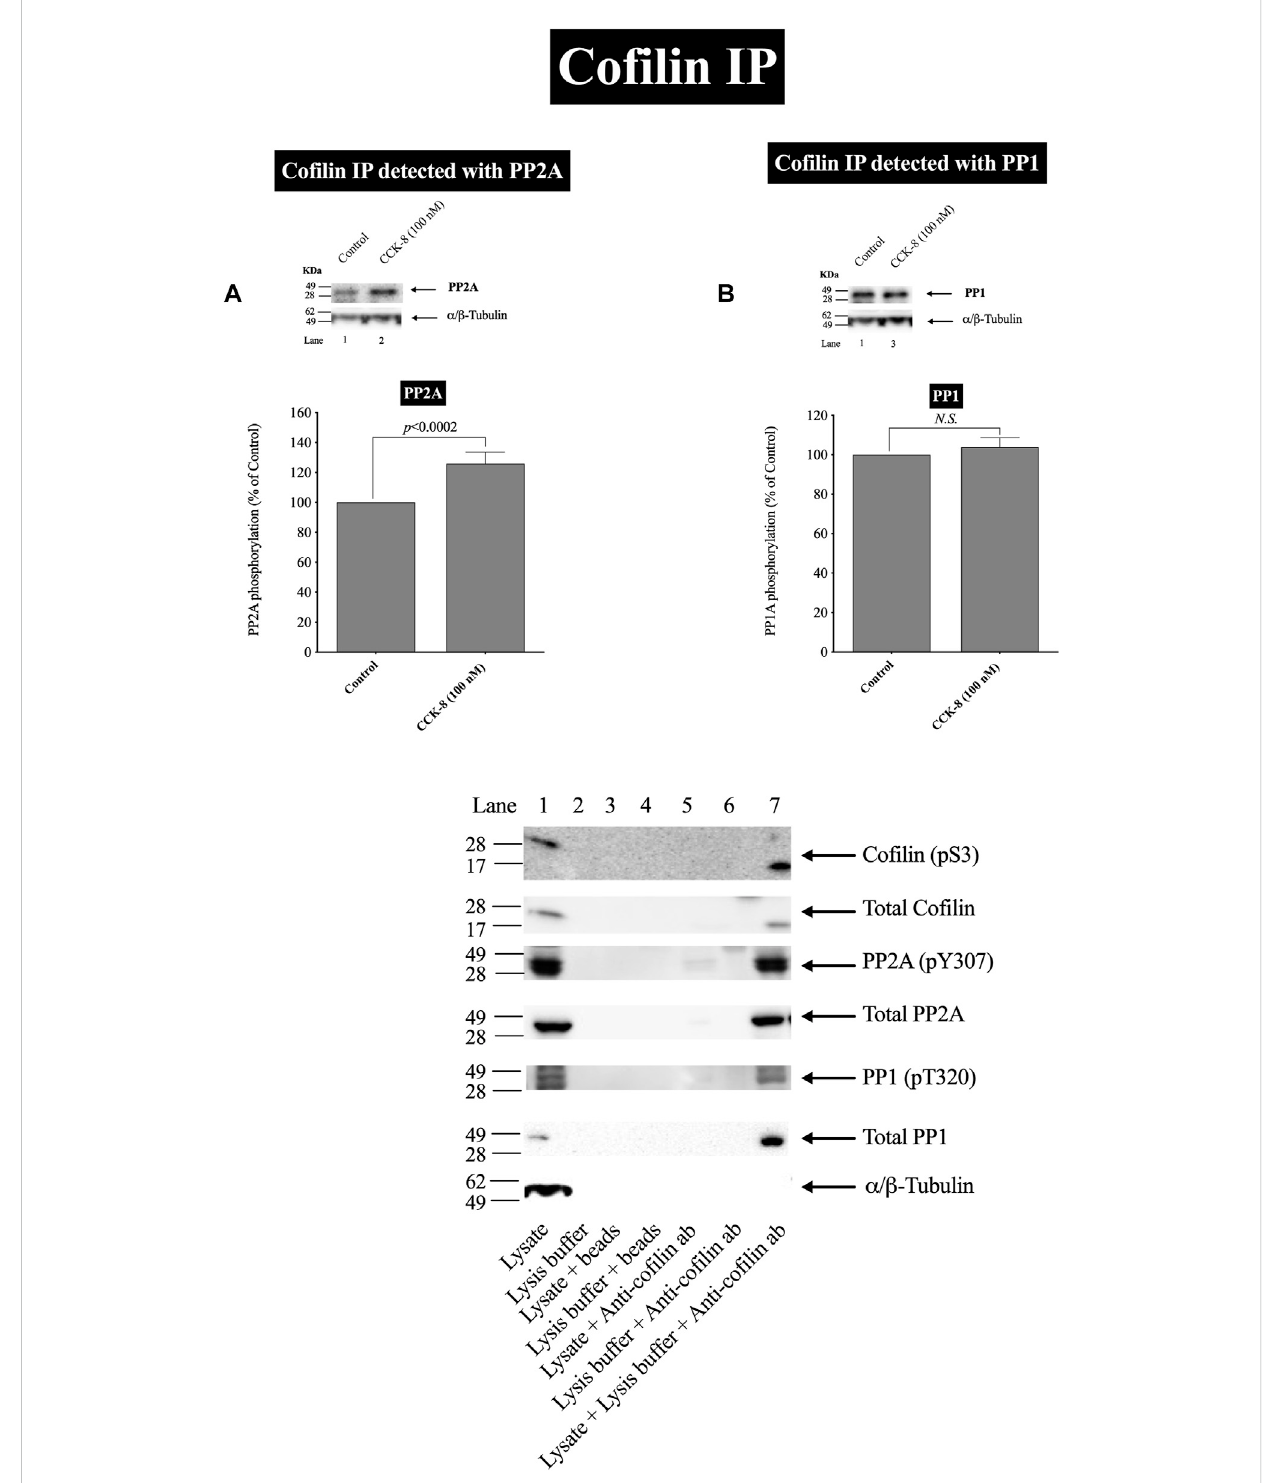
FIGURE 6 Effect of CCK-8 (100 nM) to alter co-immunoprecipitation of co fi lin with total PP2A (A) or PP1 (B) . Isolated pancreatic acini were incubated in the absence or presence of CCK-8 (100 nM) for 3 min and then lysed. Equal amounts of protein were co-immunoprecipitated with an anti-co fi lin (Santa Cruz, SC-376476) and then subjected to Westernblots using anti-PP2A and anti-PP1. Bands were visualized using chemiluminescence and quanti fi edby densitometry. Top : Results of a representative blot of four independent experiments are shown. Bottom : Means ± S.E. of at least 4 independent experiments.Resultsareexpressedas%ofbasalstimulationofthecontrolgroup. N.S. ,Nosigni fi cant.Effectofthelysate,lysisbuffer,ProteinA/Gagarose beads (beads) or Anti-co fi lin antibody (Anti-co fi lin ab) individually on phospho and totalco fi lin (pS3), phospho and total PP2A, phospho and totalPP1 and tubulin. Lysates were analyzed using co fi lin (pS3), Total co fi lin, PP2A (pY307), Total PP2A, PP1(pT320), Total PP1 and tubulin. Antibody detecting tubulin was used to verify loading of equal amounts of protein. These results of the experiments shown are representative of 4